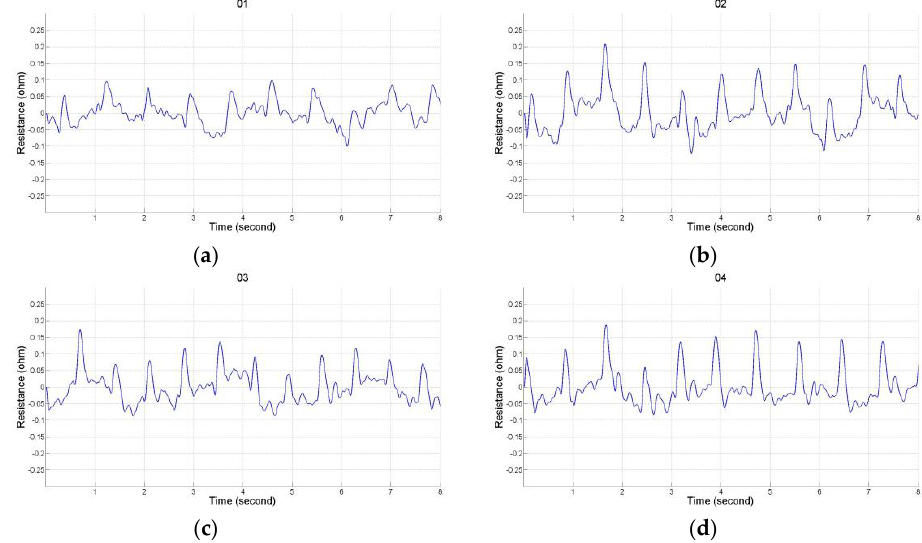
Figure 4. The electrode array is in the horizontal direction. ( a ) T 1 , T 2 are 1 and 4, R 1 , R 2 are 3 and 2; ( b ) T 1 , T 2 are 1 and 3, R 1 , R 2 are 4 and 2; ( c ) T 1 , T 2 are A and D, R 1 , R 2 are C and B; ( d ) T 1 , T 2 are A and C, R 1 , R 2 are D and B.